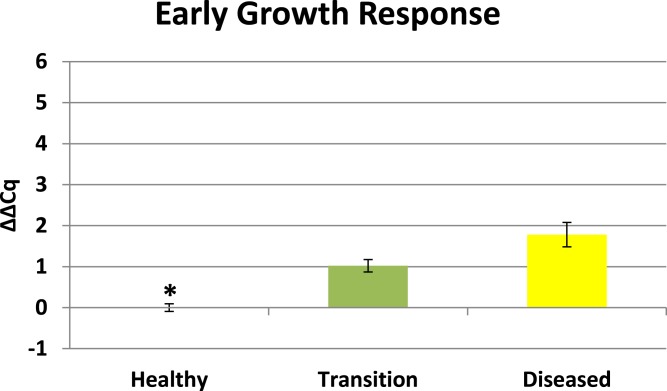
Expression of early growth response (EGR).The ΔΔCq values represent transformed expression of the EGR relative to PABP expression. An * represents a condition that was significantly different in expression (P < 0.01) relative to other conditions. Error bars represent ± SE.